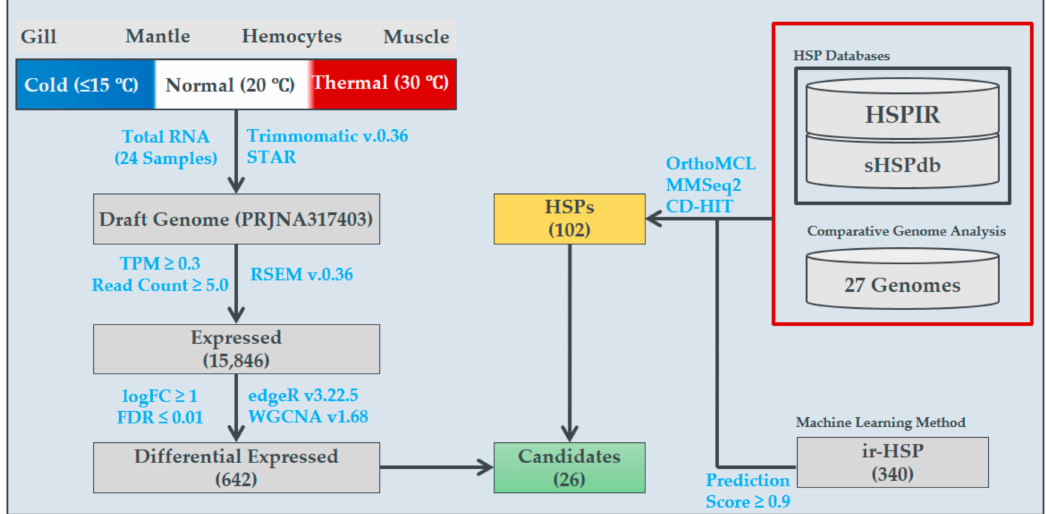
Figure 1. Illustration of the systematic bioinformatics analyses performed to elucidate temperature-specific gene expression in H. discus hannai (Pacific abalone), as well as heat shock protein (HSP) expression